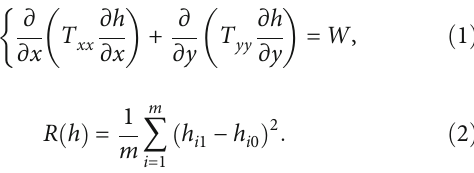
Formation. Drill number